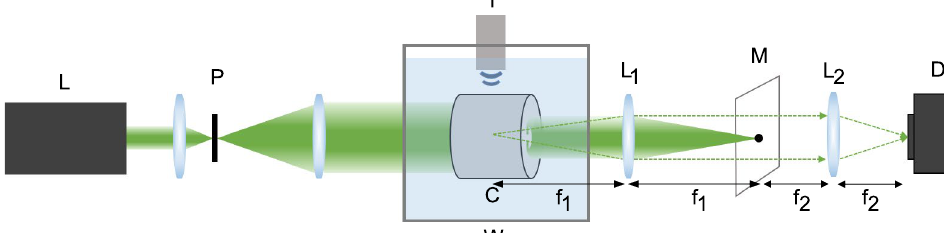
Figure 6. Schematic diagram of the schlieren imaging setup. L: 532 nm laser, P: pinhole, T: transducer, C: Penrose cavity, W: water tank, M: mask, D: detector. A 2 f – 2 f ′ imaging system (lenses L 1 and L 2 with 200 cm and f 2 75 cm, respectively) is used to image the intensity patterns of acoustic resonant f 1 = =